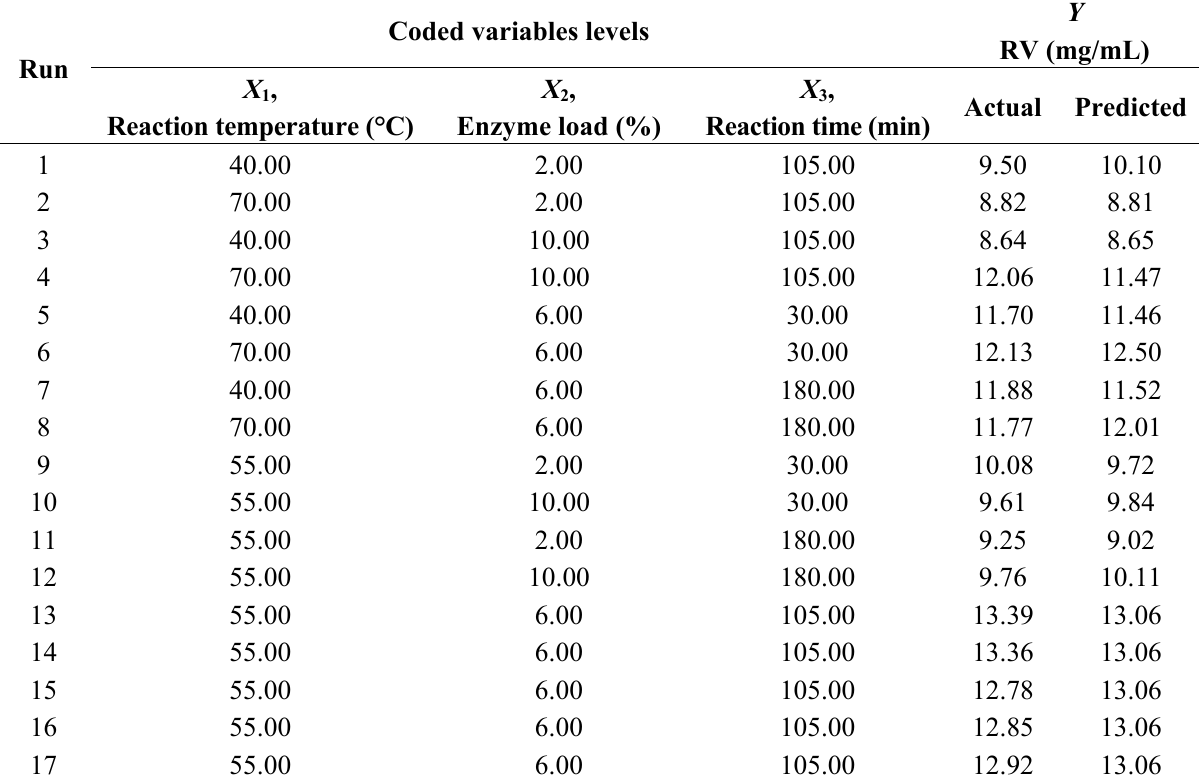
Table 1. Box-Behnken experimental design with the independent